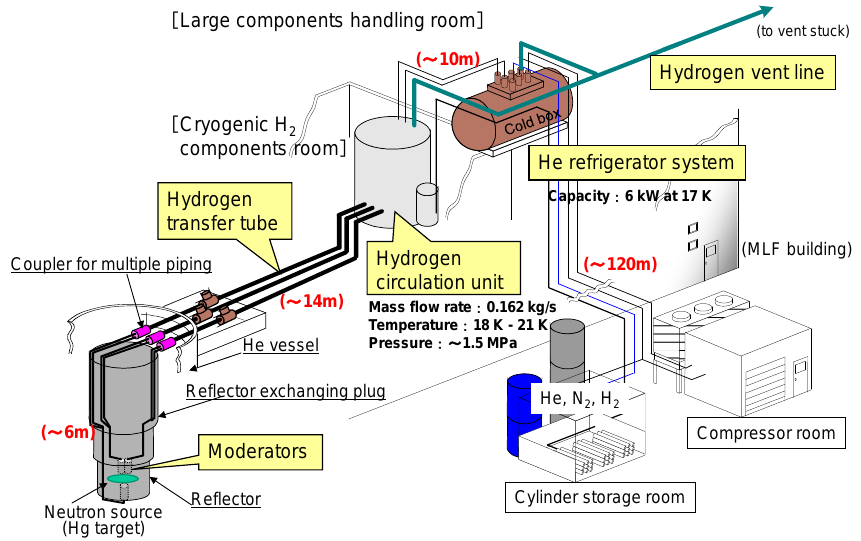
Figure 16. Illustration of cryogenic system component arrangement in Materials and Life Science Experimental Facility (MLF) building.